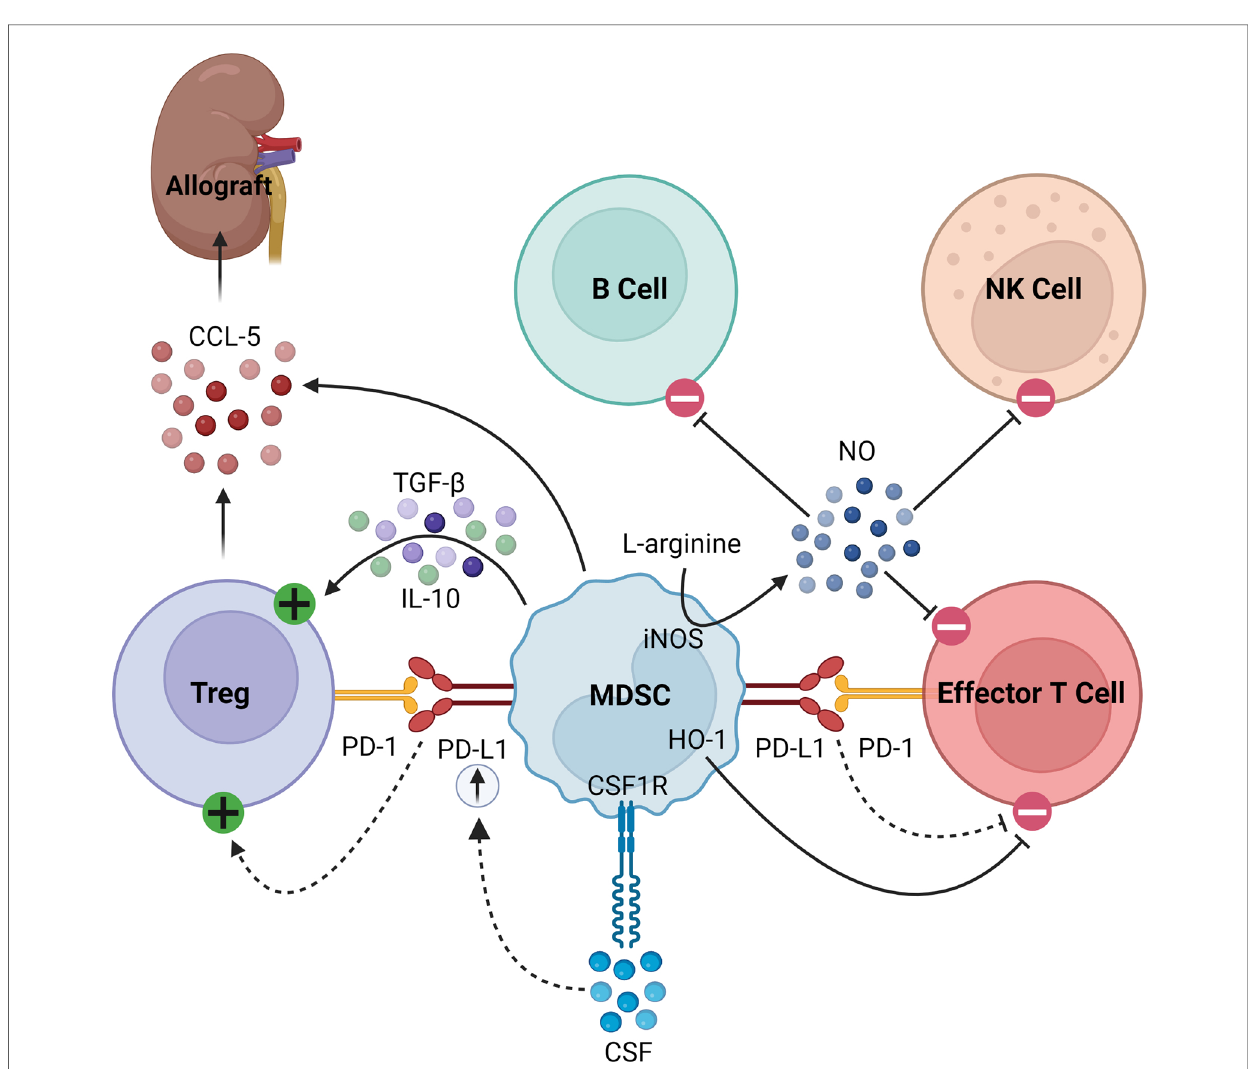
FIGURE 1 Immunosuppressive mechanisms of MDSCs. MDSCs express PD-L1, which activates Tregs and inhibits effector T cells by binding its cognate PD-1. In response to CSF/CSF1R signaling, MDSCs upregulate PD-L1. They express HO-1, which similarly inhibits effector T cells. MDSCs express iNOS which consumes L-arginine to produce NO, the latter of which then inhibits B cells, NK cells, and effector T cells. Finally, they produce TGF- β and IL-10 to activate Tregs and CCL-5 to recruit Tregs to the